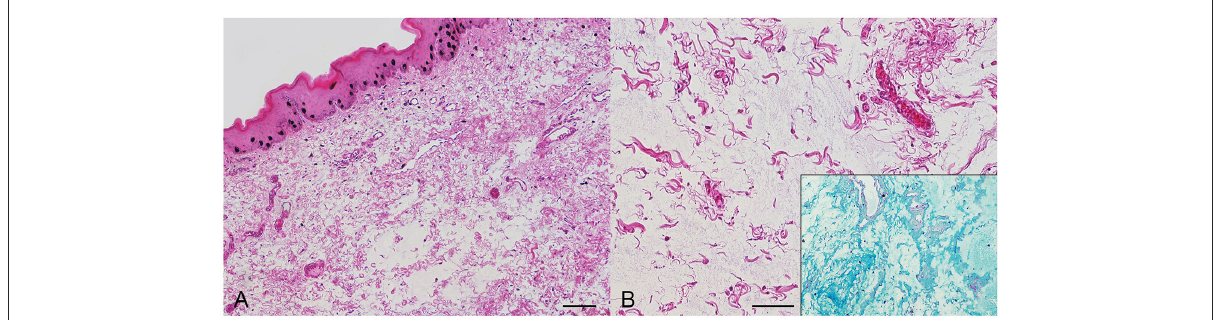
FIGURE2 Dog, histologic preparation from a sublingual mass. (A) The subepithelial connective tissue is expanded by increased clear spaces. Hematoxylin and eosin. (B) At closer magnification, collagen bundles are separated by abundant, granular, amphophilic material, staining pale blue with alcian blue (inset), consistent with mucin. Hematoxylin and eosin. Bars, 100 µ m.